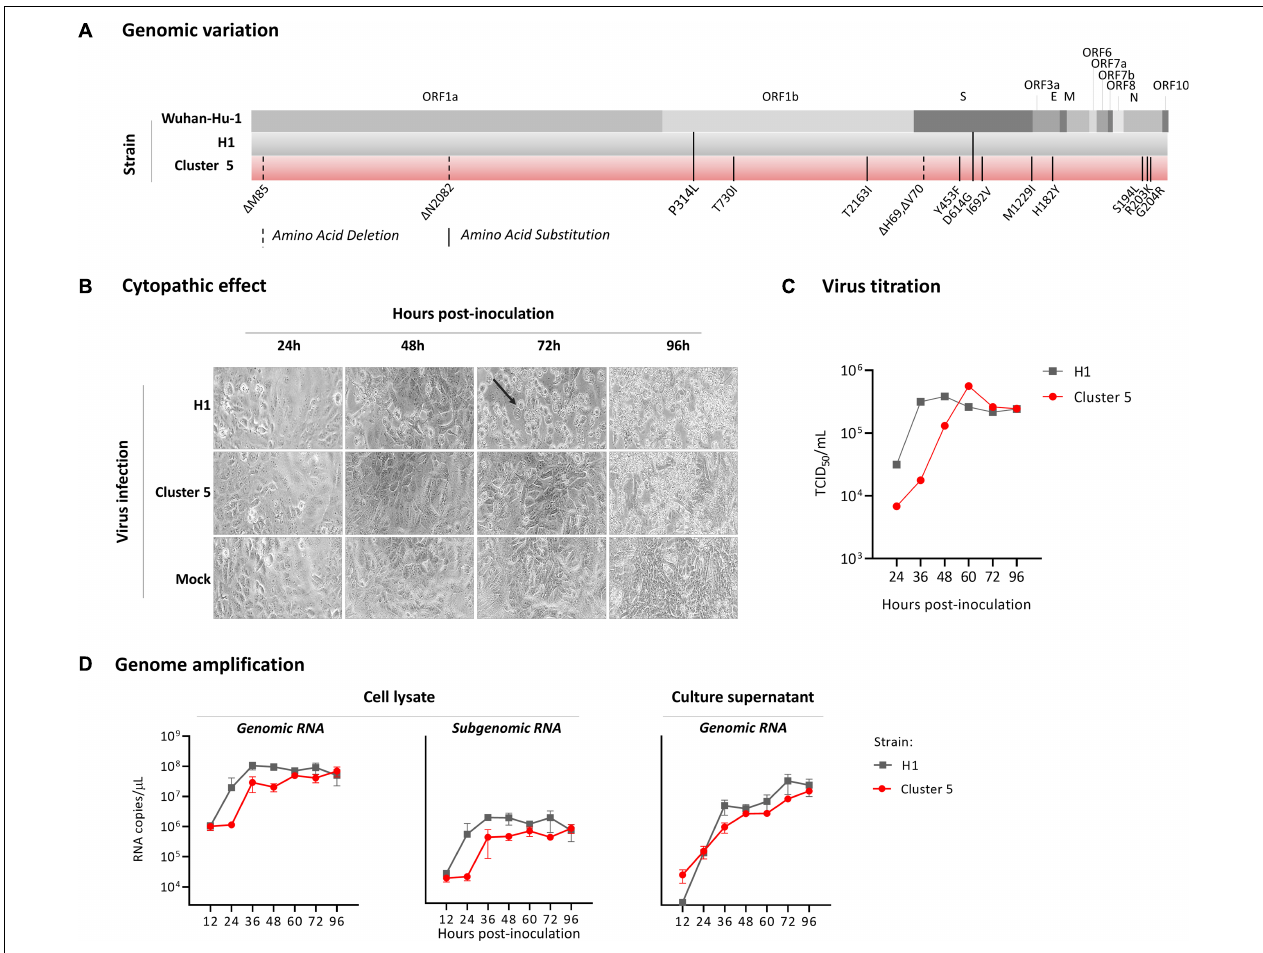
FIGURE 2 | Genomic characterization and growth kinetics of the SARS-CoV-2 Cluster 5 variant in Vero-E6 cells. (A) Amino acid changes identified in the SARS-CoV-2 Cluster 5 variant and a Danish SARS-CoV-2 strain (H1) isolated in March 2020 relative to the reference strain Wuhan-Hu-1. (B) Temporal cytopathic effect of Vero-E6 cells following infection with the two virus strains at a multiplicity of infection (MOI) of 0.01. The arrow indicates the characteristic rounding of SARS-CoV-2 infected cells. (C) Temporal increase in H1 and Cluster 5 virus levels following inoculation of Vero-E6 cells at an MOI of 0.01. At the indicated time points, the virus titre was determined in a SARS-CoV-2-specific anti-nucleocapsid protein ELISA and the TCID 50 /mL calculated using the Reed and Muench method. (D) Quantitation of SARS-CoV-2 E gene genomic and subgenomic RNA in infected Vero-E6 cells and cell culture supernatant. Cells were infected at a multiplicity of infection of 0.0125 for 1 h, washed three times to remove all inoculum, overlaid with culture media, and cells and culture supernatant harvested at the indicated time